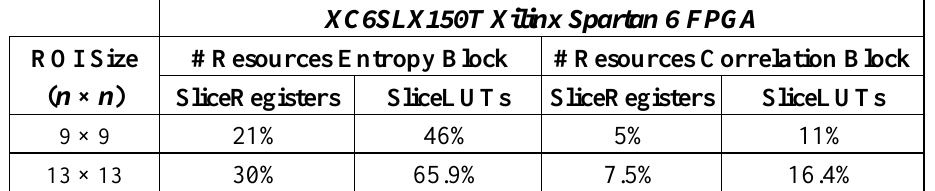
Table 2. Resources used on a XC6SLX150T: Slice Registers and Slice LUTs.